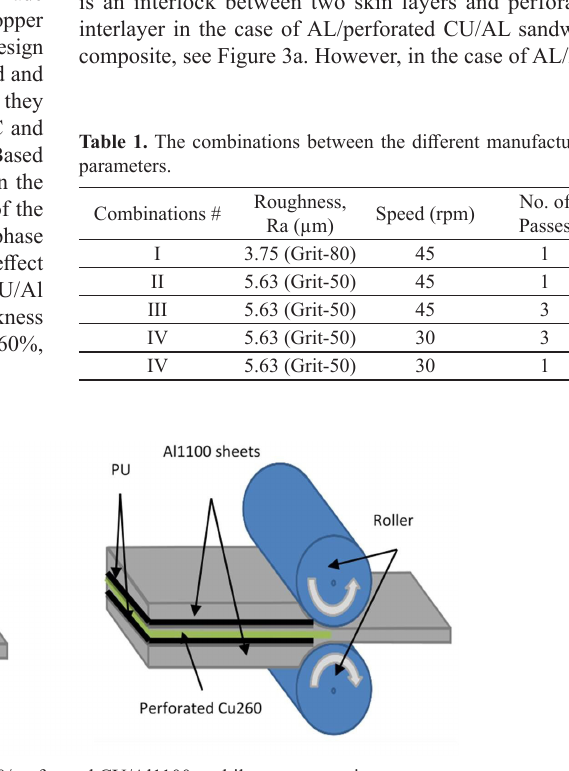
Figure 1. Schematic of manufacturing process of the Al1100/perforated CU/Al1100 multilayers composites.